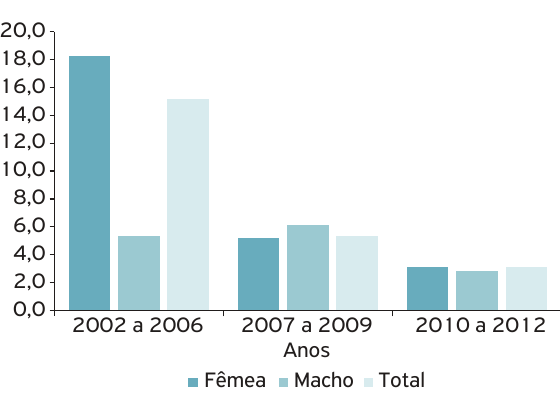
Gráfico 5. Percentual de bovinos de propriedades rurais com anticorpos contra proteínas não capsidais do vírus da